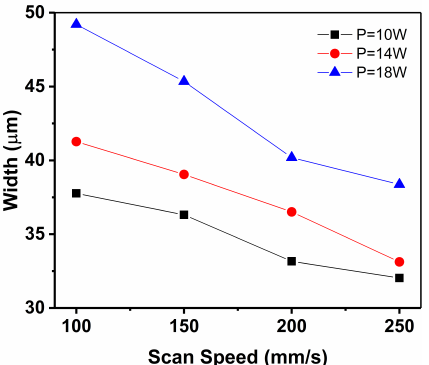
Figure 6. Effect of laser power and scan speed on